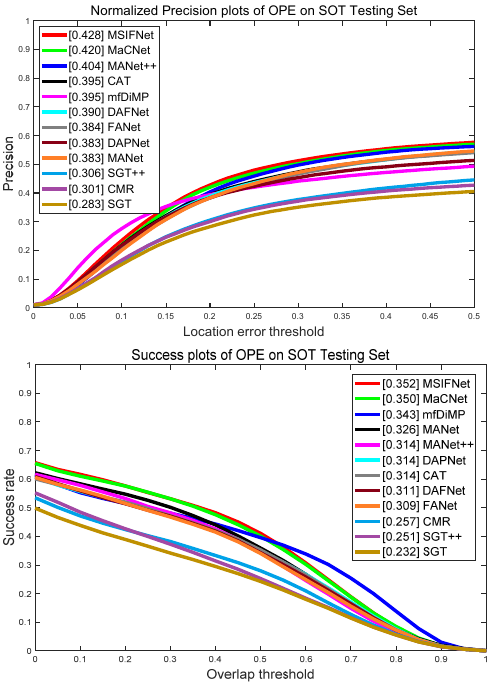
Figure 9. Evaluation curves for NPR/SR metrics on LasHeR.